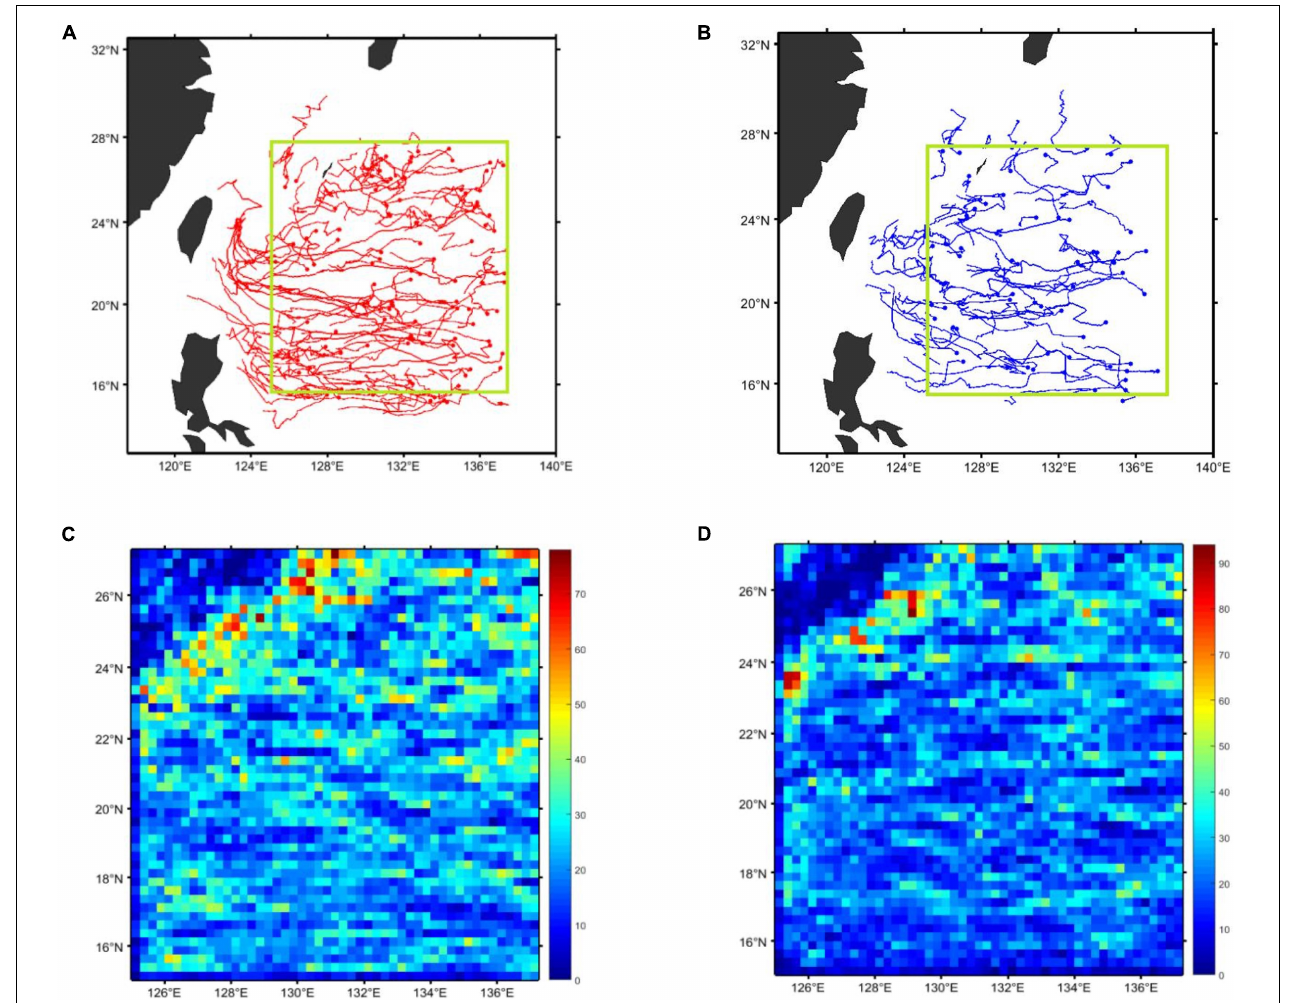
FIGURE 2 | Propagation paths and density distribution of mesoscale eddies in the study area. (A) Propagation paths of cyclonic eddies. (B) Propagation paths of anticyclonic eddies. (C) Density distribution of cyclonic eddies. (D) Density distribution of anticyclonic